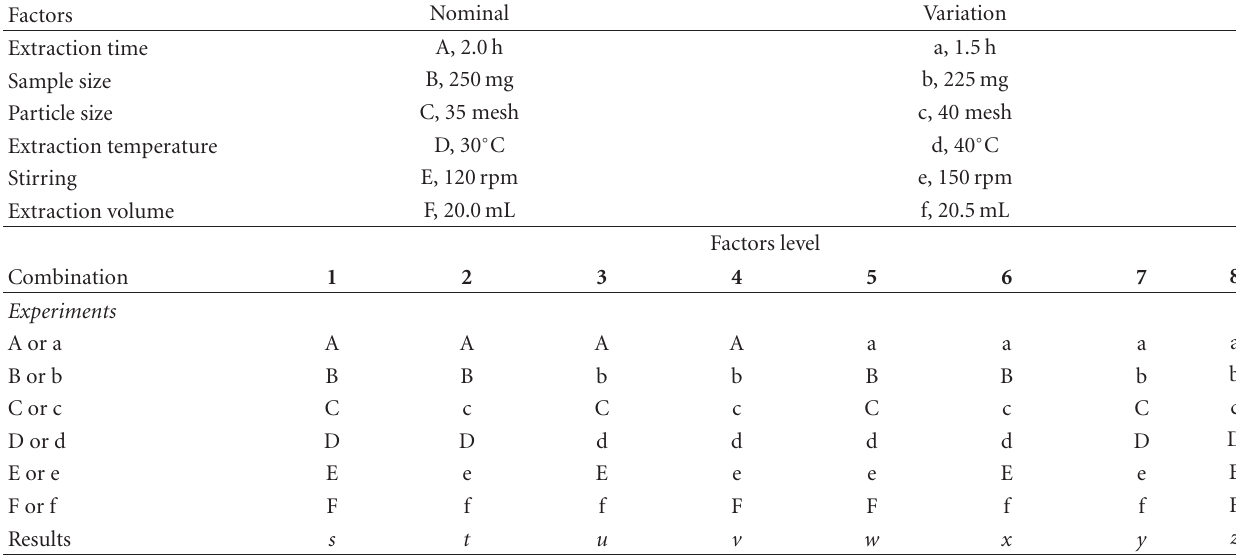
Table 1: Combination of factors to assess the robustness of